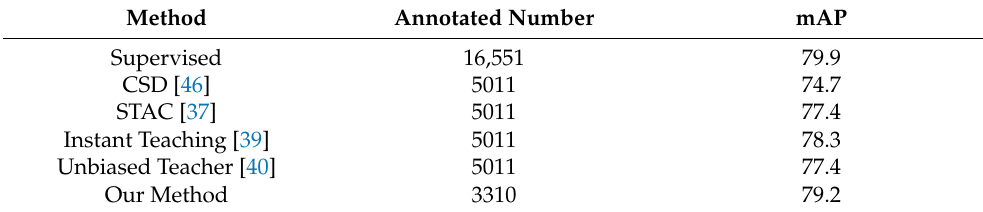
Table 1. Comparison with state-of-the-art SSL approaches on PASCAL VOC dataset.